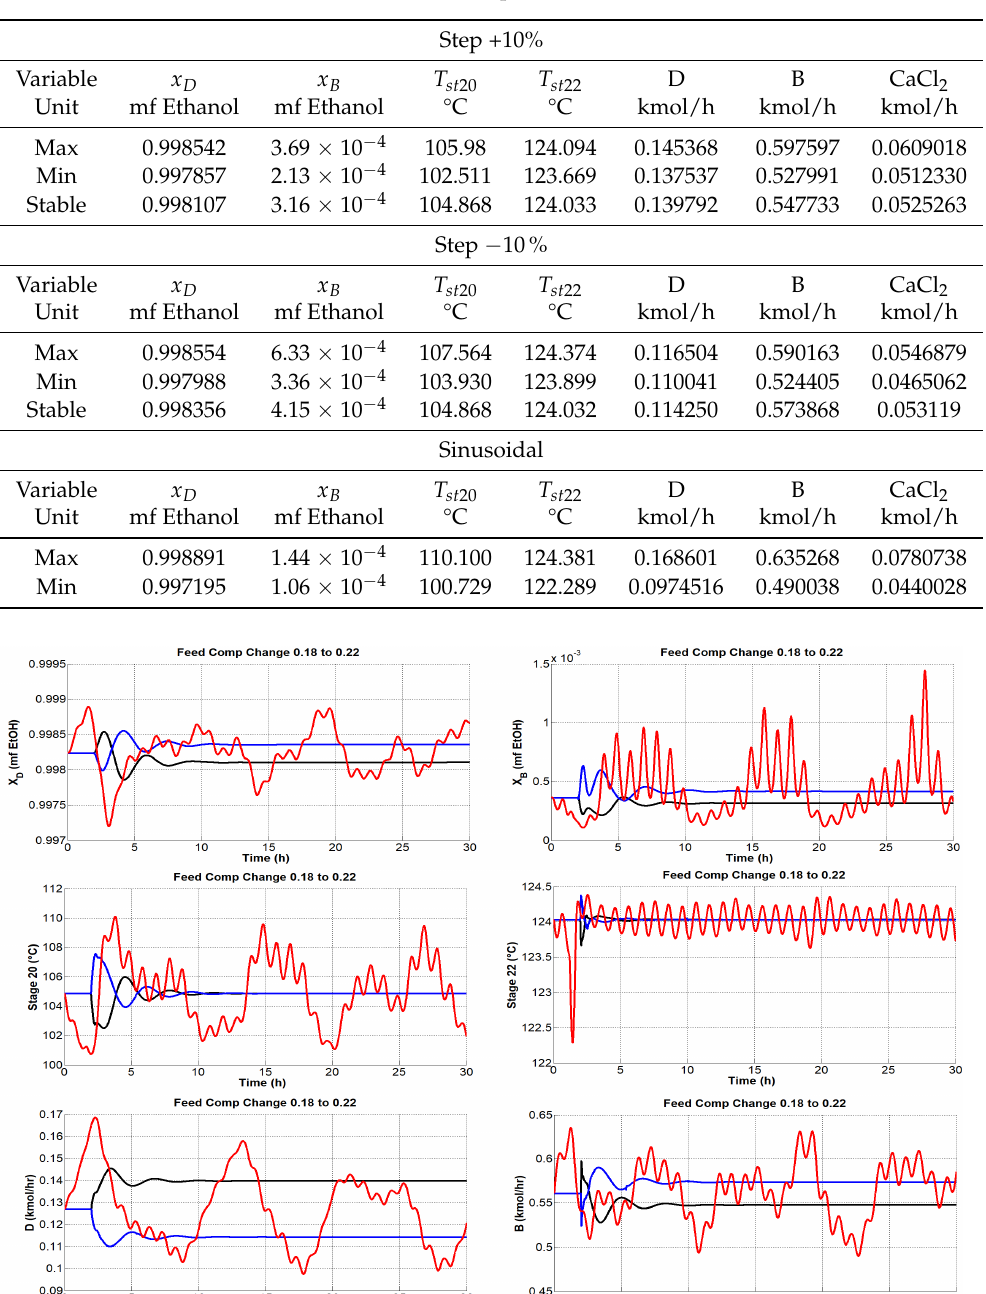
Table 10. The behavior of the process using the structure DV. Maximum, minimum, and stabilization values in the event of disturbances in the feed composition.